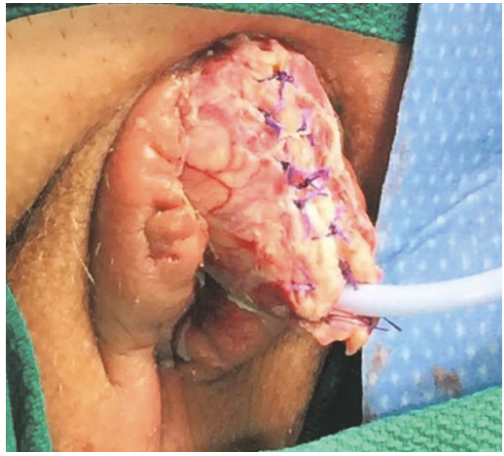
Figure 5: Remaining penile shaft after glansectomy and partial penectomy.